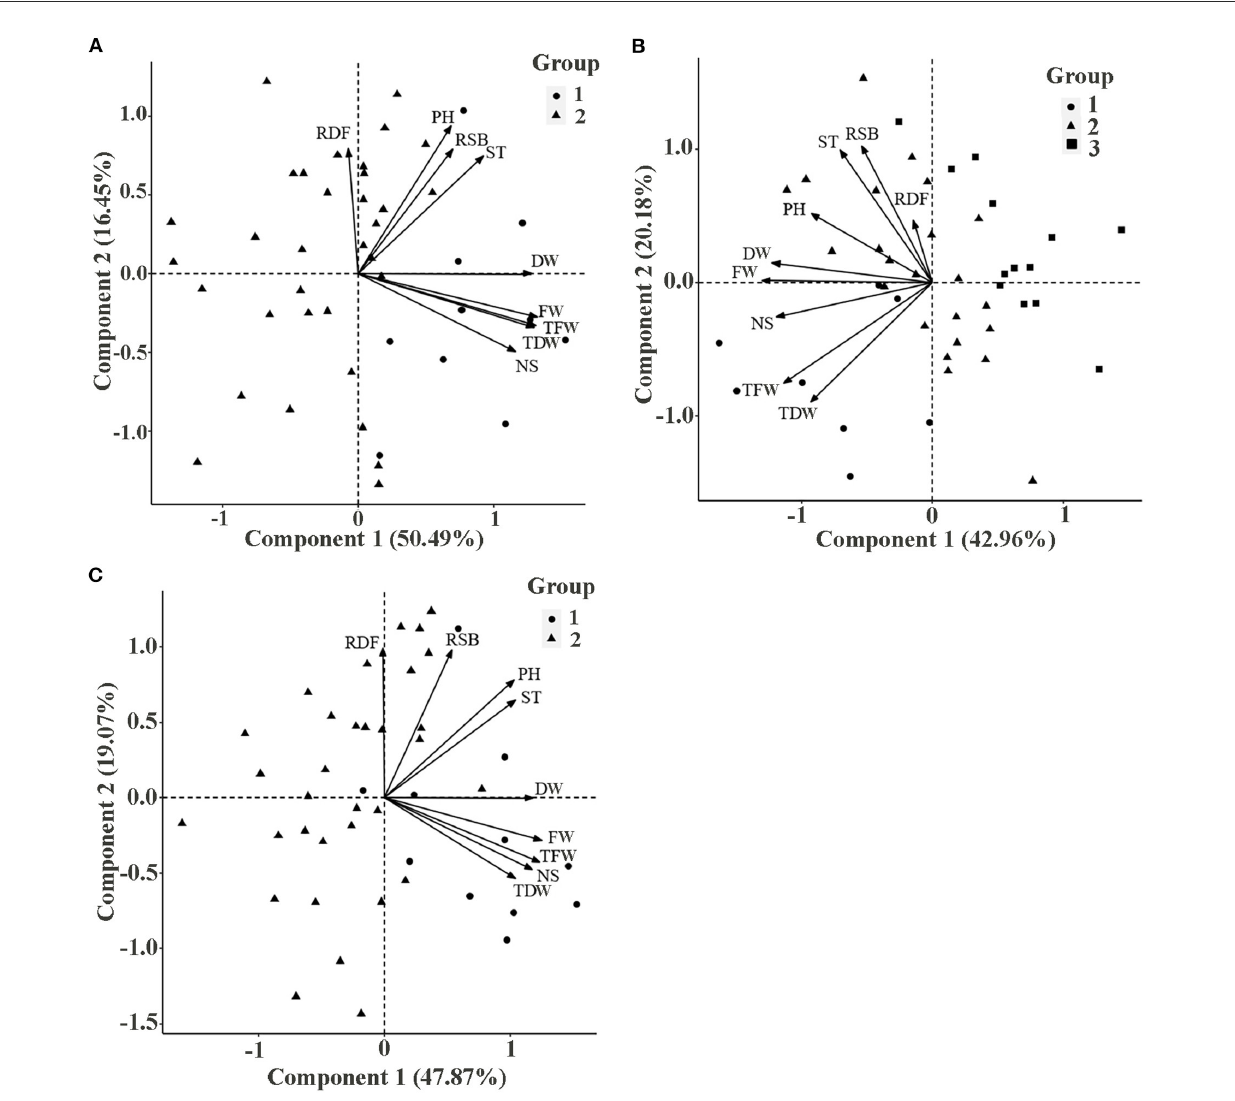
FIGURE2 Principal component analysis of 9 agronomic traits of 44 alfalfa varieties in (A) 2019, (B) 2020, and (C) interannual. ST, stem thickness; PH, plant height; NS, number of branches; RSL, stem biomass/leaf biomass ratio; FW, fresh weight; DW, dry weight; RDF, dry weight/fresh weight ratio; TFW, total fresh weight; TDW, total dry